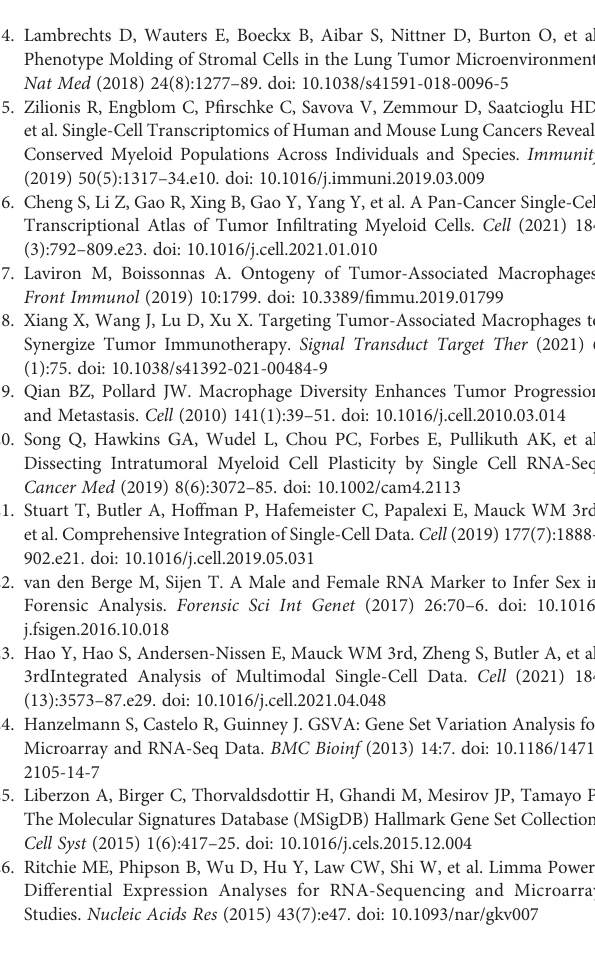
Supplementary Table 1 | Clinical characteristics of Non-Small Cell Lung Cancer patients. Supplementary Table 2 | Gene lists of signatures used to explore the functional heterogeneity of Immune Cells. Supplementary Table 3 | Differentially Expressed Genes among Myeloid clusters in the discovery single-cell data and validation single-cell data